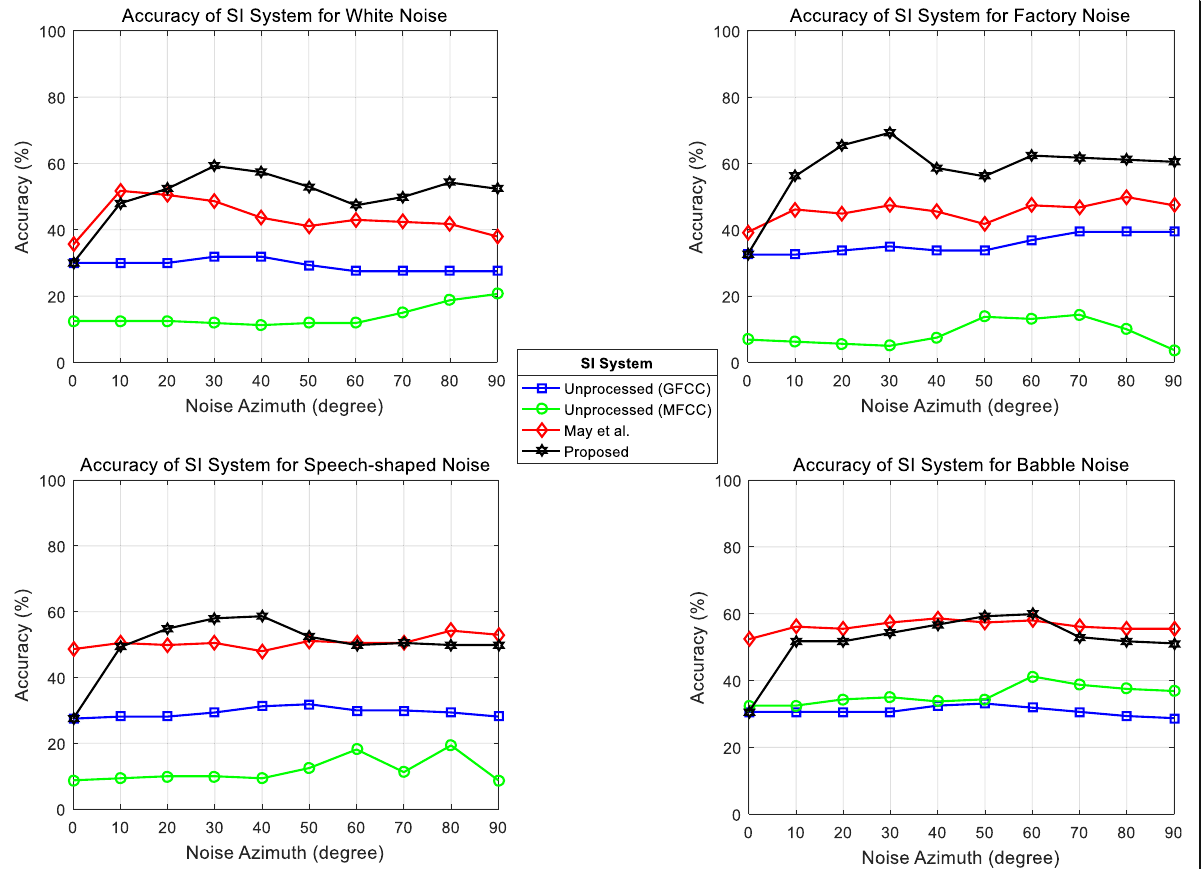
Fig. 6 The accuracy of the SI systems obtained in anechoic and additive noise conditions with four types of noises at SNR = 0